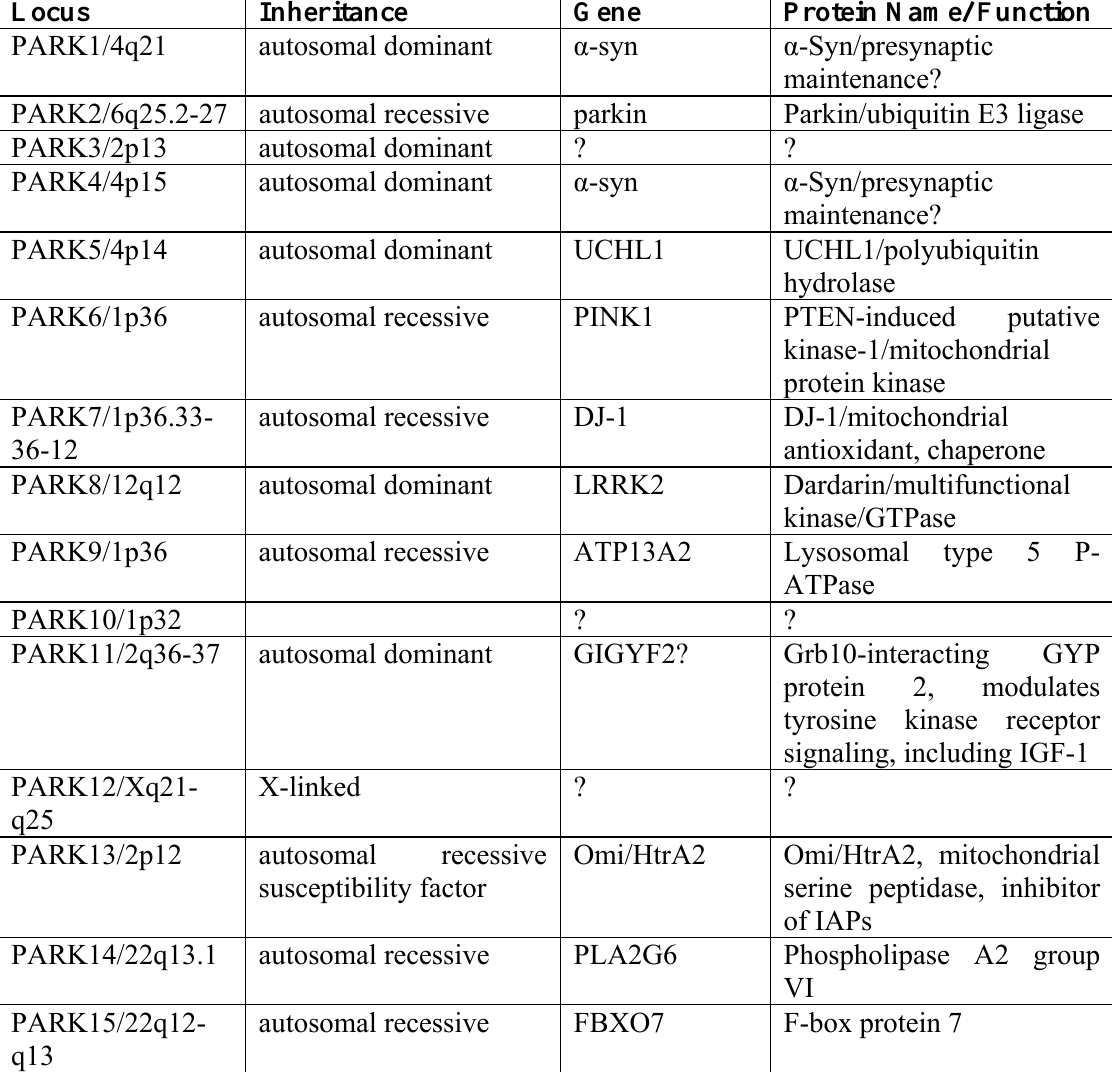
Table 3. Mutant Genes Linked to Familial